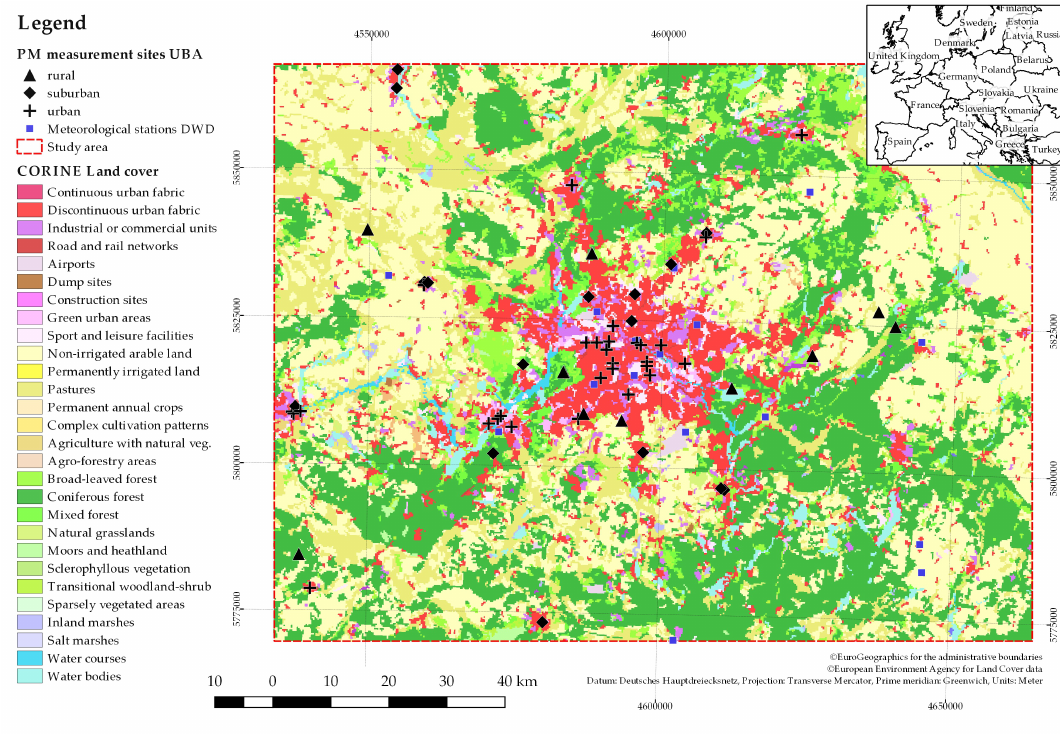
Figure 1. Geographical extent of the study area. Different land cover classes are colored, positions of meteorological stations and PM10-measurement sites are